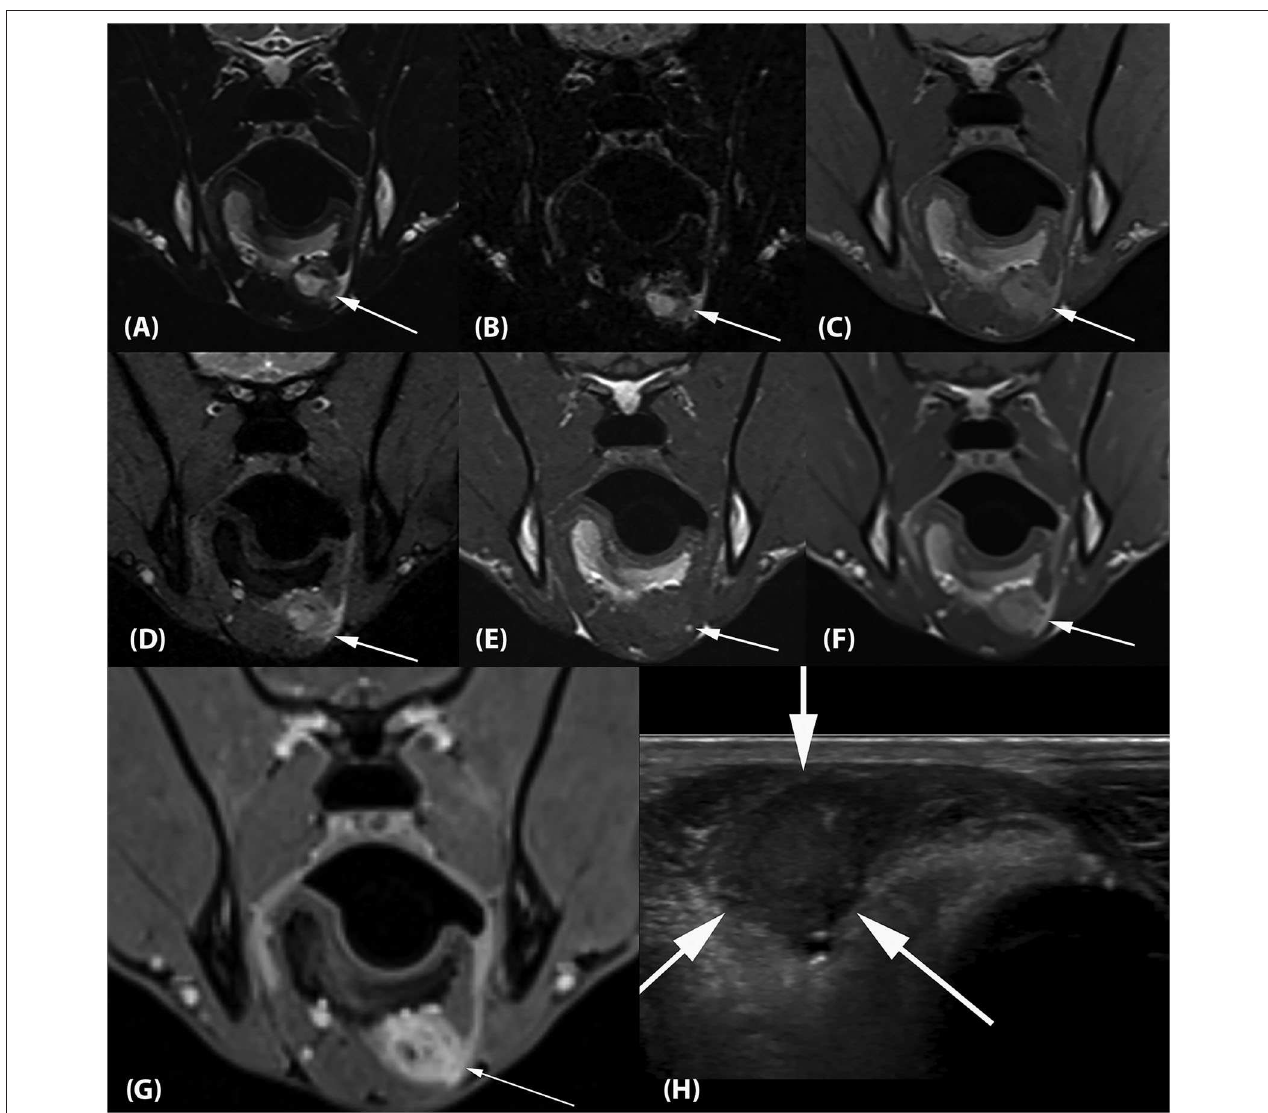
FIGURE 3 | (A) Transverse T2-weighted, (B) T2-FLAIR, (C) PD-weighted, (D) T2*-weighted GRE, (E) T1-weighted pre contrast, (F) T1-weighted post contrast and (G) T1-weighted Volume Interpolated GRE images with fat saturation (“VIBE”) at the level of the mandibular angle. There is an ∼ 2.0 × 1.3 × 1.8cm (L × H × W) ovoid lesion associated with the left side of the tongue base with imaging characteristics identical to the lesion associated with the left medial pterygoid muscle (arrows). (H) Transverse ultrasonographic image of the lesion at the tongue base which is hypointense, fairly homogeneous, and well-circumscribed (arrows). The impression of the lesion being right- rather than left-sided is artifactual and related to a change in tongue position between the MRI and ultrasound